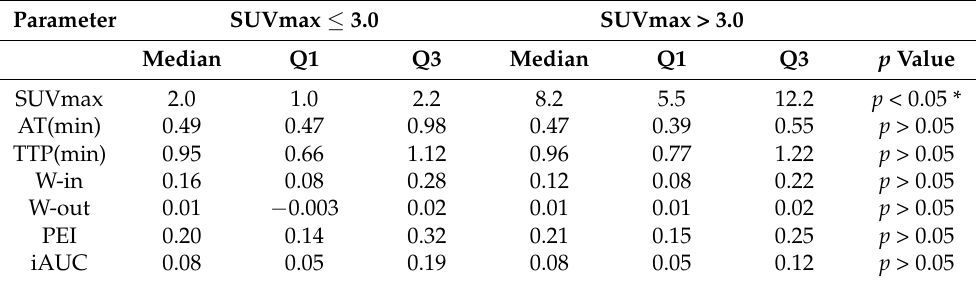
Table 3. Comparison of parameters between malignant lesions with SUVmax ≤ 3.0 and SUVmax > 3.0.